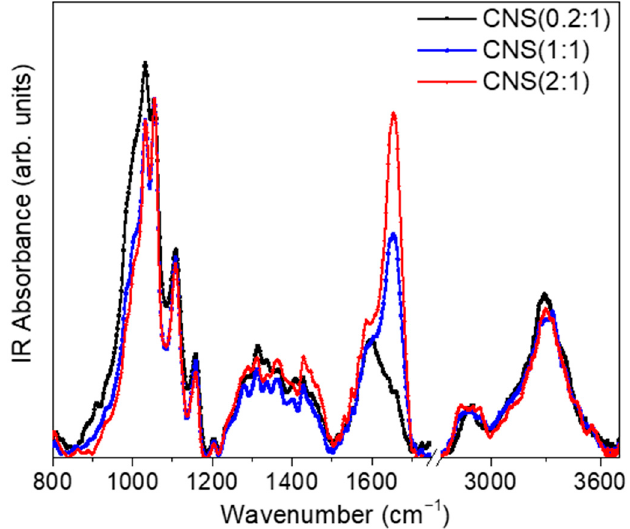
Figure 2. FTIR-ATR spectra in the 800–3700 cm − 1 wavenumber range, at T = 300 K, of dry CNS (0.2:1) (black line), CNS (1:1) (blue line) and CNS (2:1) (red line) samples.